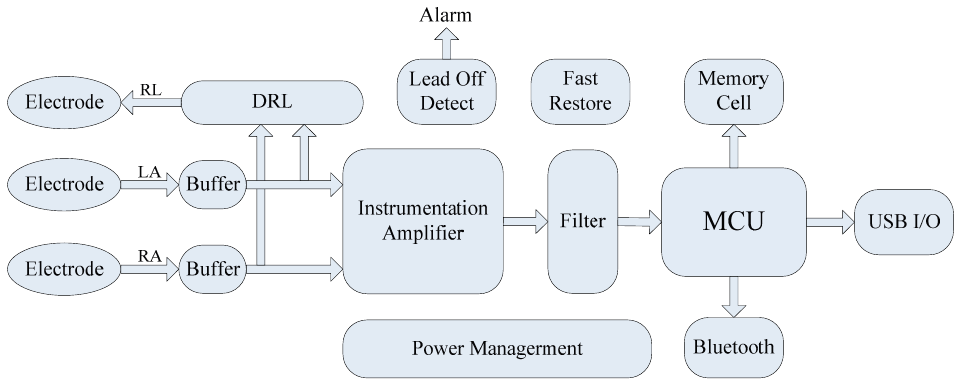
Figure 2. Architecture of traditional acquisition